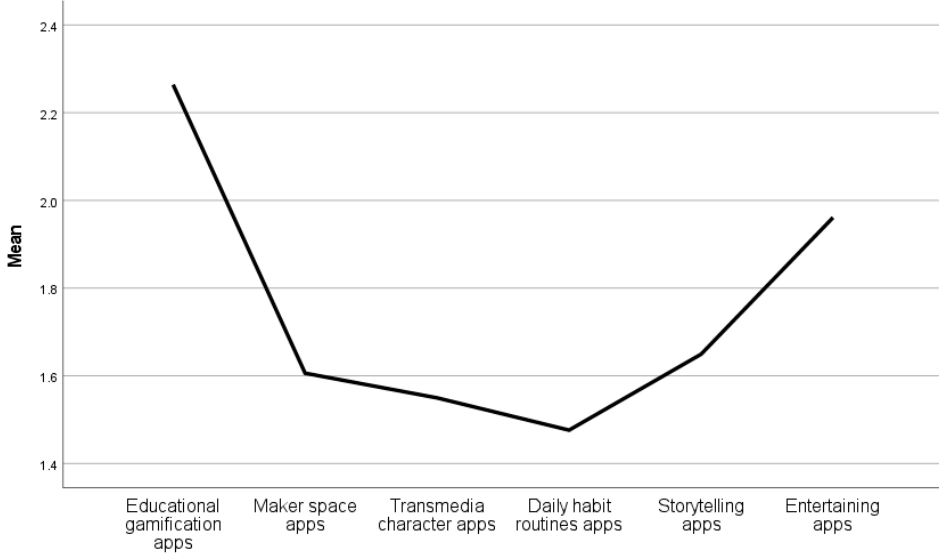
Figure 9. Application types that parents offer to a child.